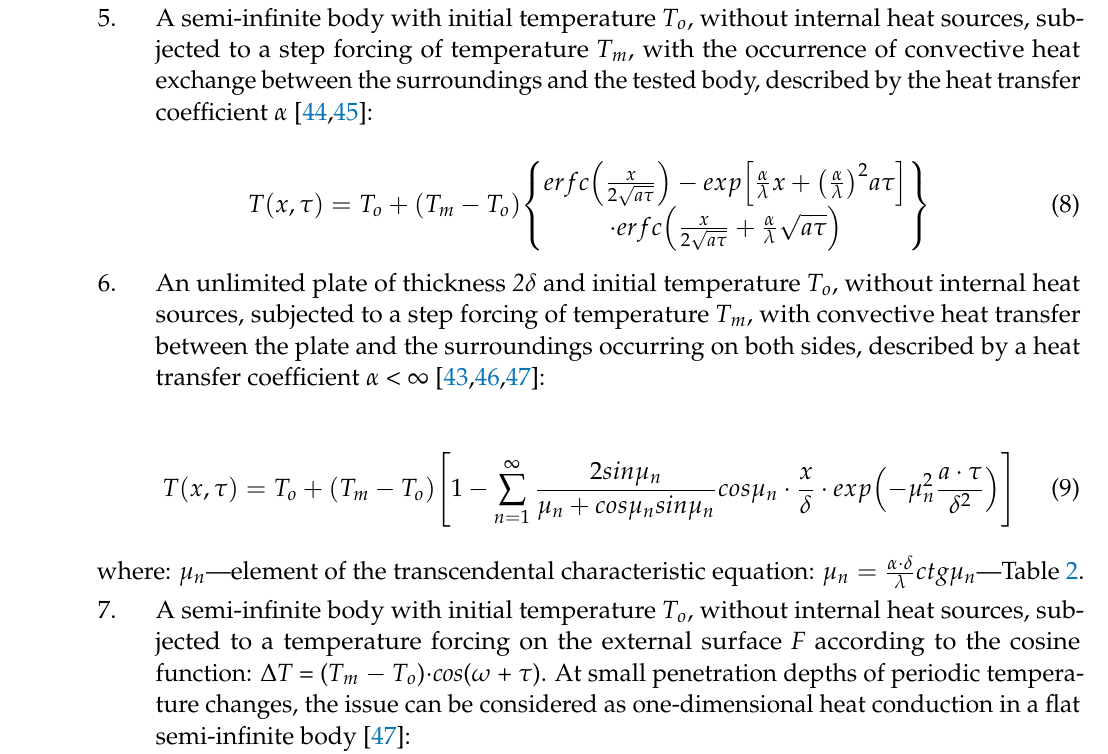
Table 2. Elements of the transcendental characteristic equation µ n = α · δ